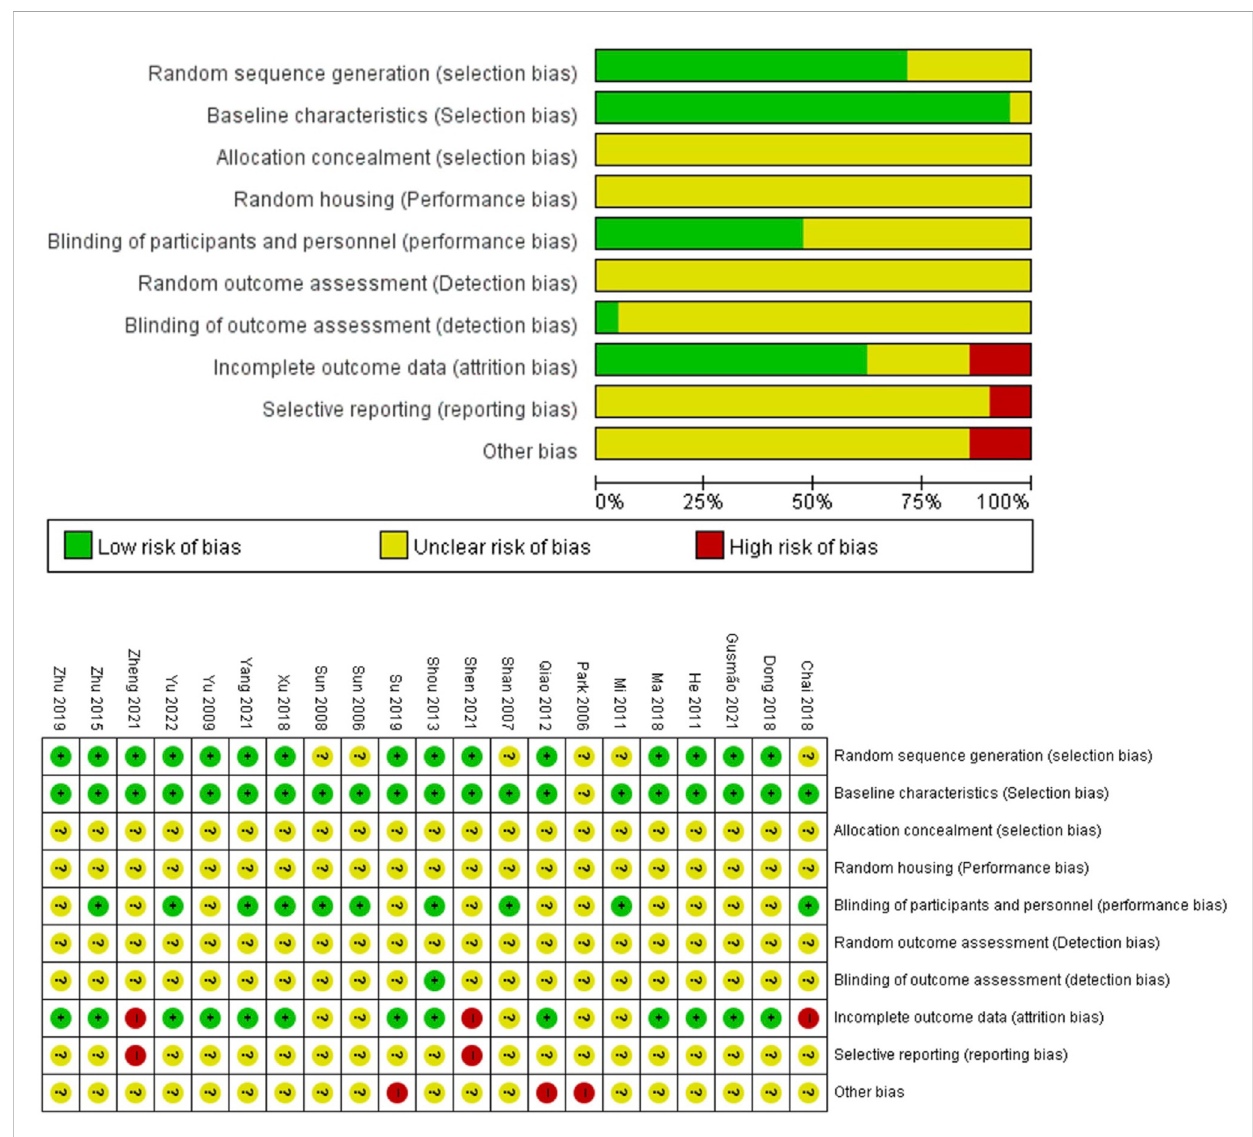
FIGURE 2 Quality